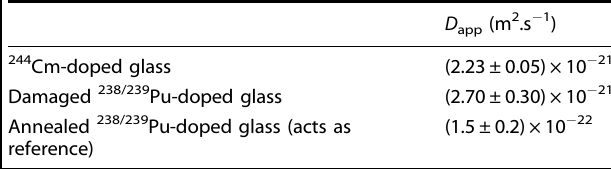
Table 2. Apparent diffusion coef fi cient ( D app ) calculated from the linear regression obtained by fi tting NL B versus √ t in Fig.